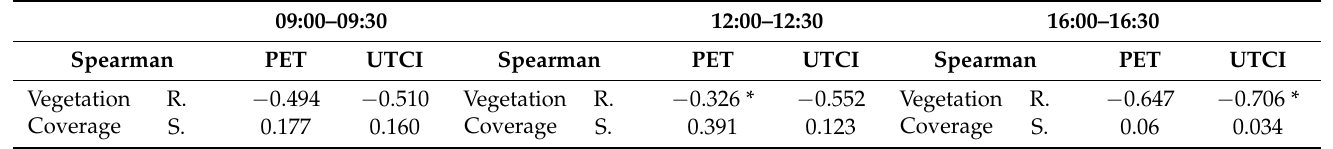
Figure 11. The PET and UTCI for different sections during the three time periods. Table 4. The Spearman correlation coefficients of the vegetation coverage and PET&UTCI.